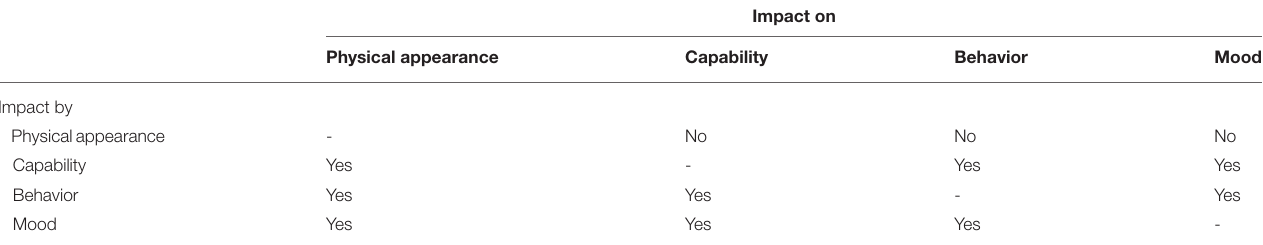
TABLE 2 | Hypothesised direction of interactions between the four domains represented in the conceptual framework for HRQOL in dogs with osteoarthritis ( Figure 2 ). Impact on Physical appearance Capability